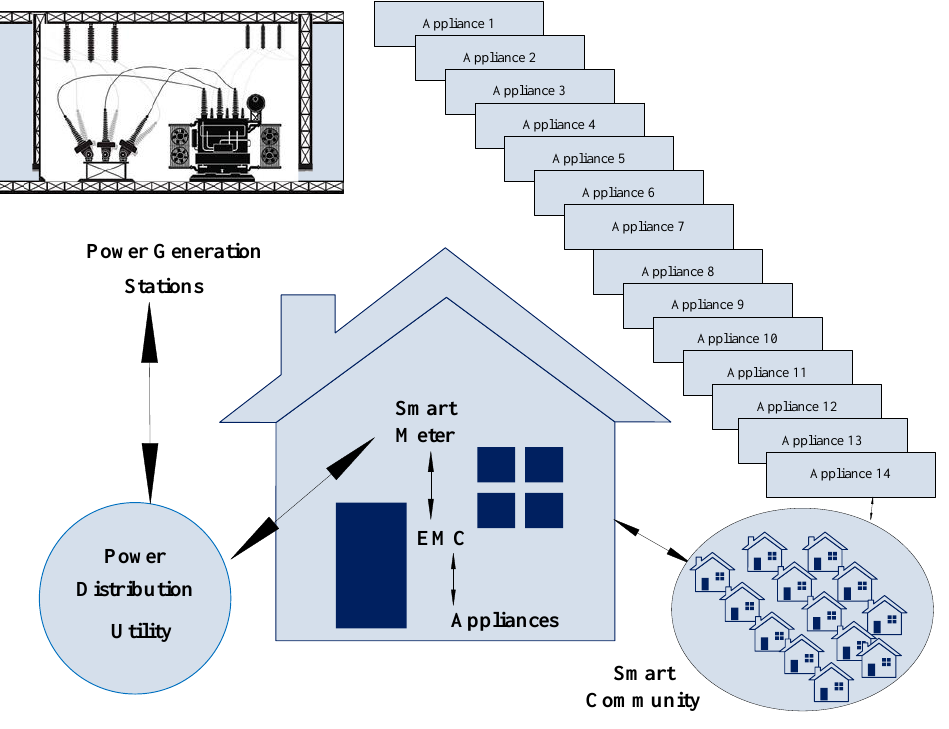
Figure 1. Proposed system